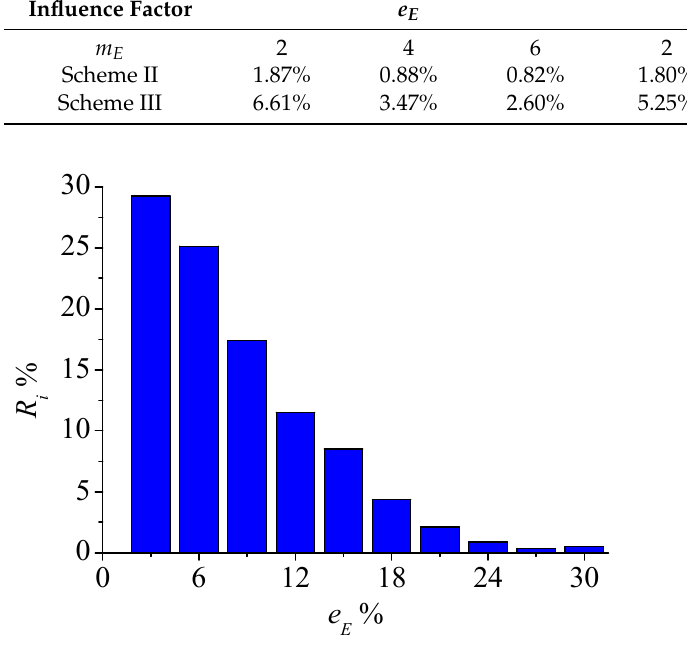
Figure 5. Statistics of the inversion error of Young’s modulus field of scheme III.